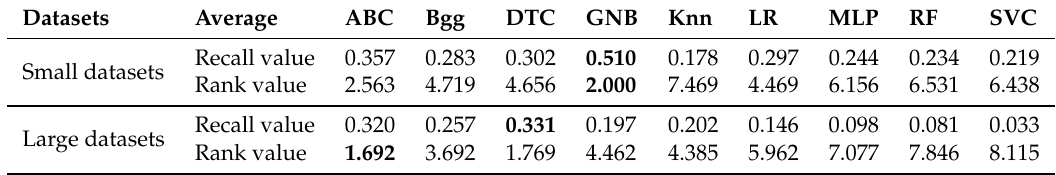
Table 5. Average recall value and Friedman rank of 9 classifiers on different